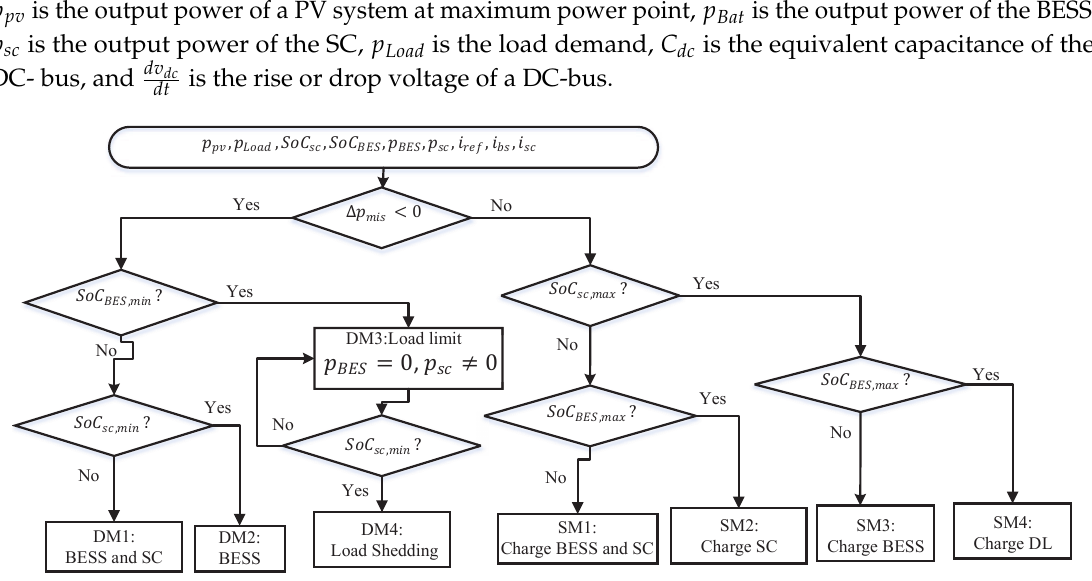
Figure 5. Flow chart of the proposed EMS-based control